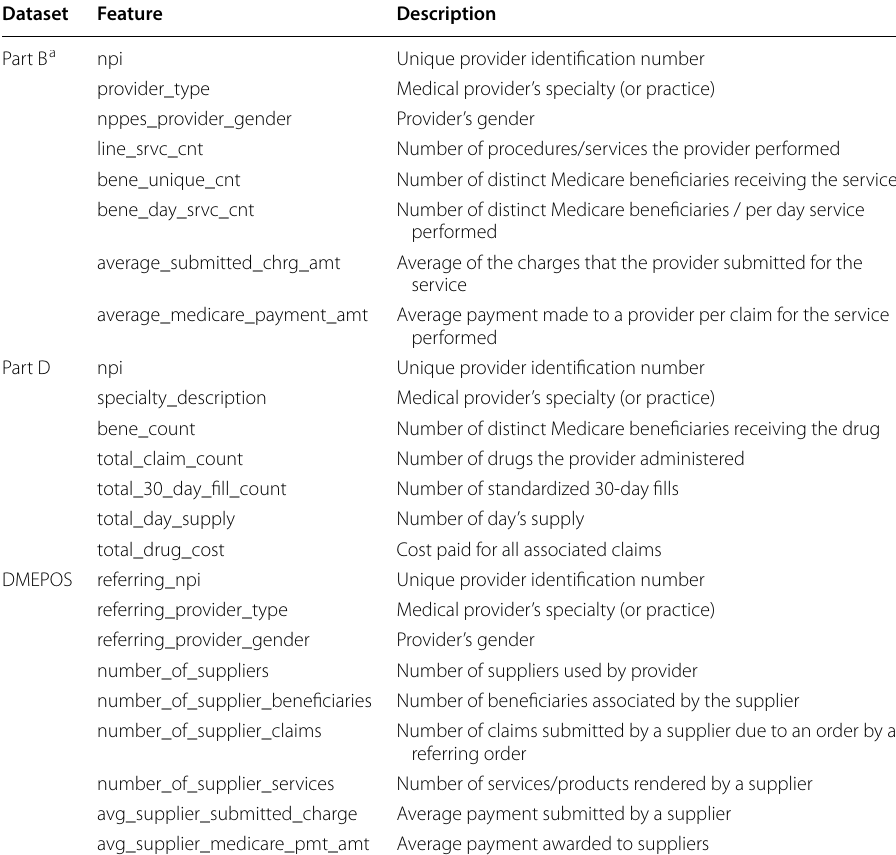
Table 2 Selected features from